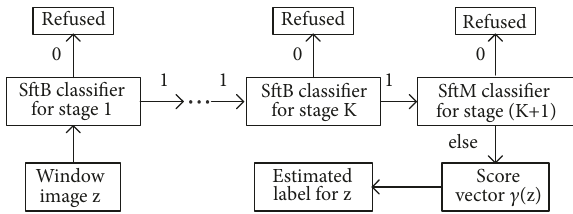
Figure 1: The flowchart of window image classification using softmax-based cascade